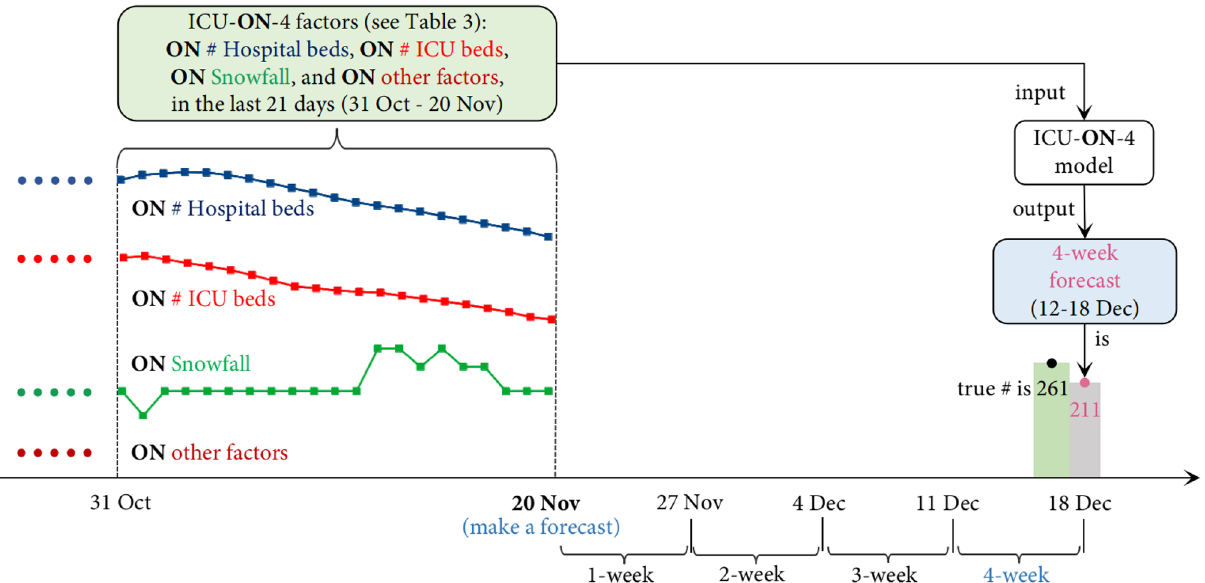
Figure 1. An example of target-region-horizon-specific forecast: forecasting the weekly average number of ICU beds ( target ) needed by COVID-19 patients in Ontario ( region ) for 4-week ( horizon )—i.e., for 22 to 28 days after 20 Nov 2020 (that is, 12–18 /